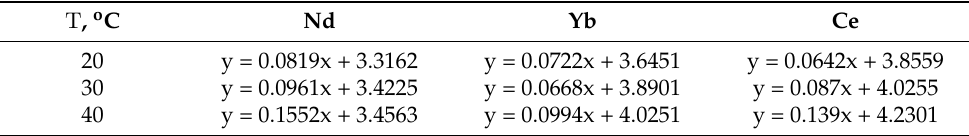
Figure 5. Time-dependent logarithm of weight, obtained by dissolving lanthanide carbonate in 1 M potassium carbonate solution at different temperatures: ( a ) for Ce; ( b ) for Nd; ( c ) for Yb. The resulting dependencies are satisfactorily approximated by the linear dependen- cies shown in Table 6. The value of approximation validity was less than 96%. Table 6. Degree of extraction versus time and temperature in linear form.